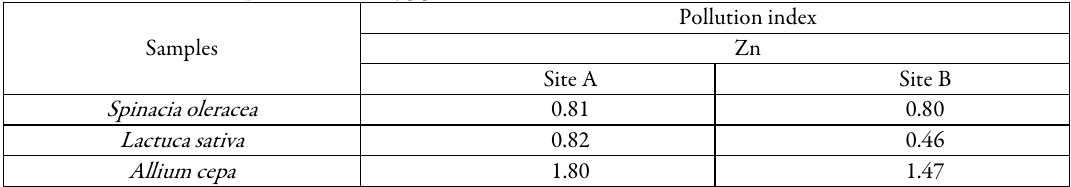
Table 5. Estimated pollution index (µg g -1 ) Pollution index Samples Zn Site A Site B Spinacia oleracea 0.81 0.80 Lactuca sativa 0.82 0.46 Allium cepa 1.80 1.47 NB: Pollution index >1 indicate higher level of